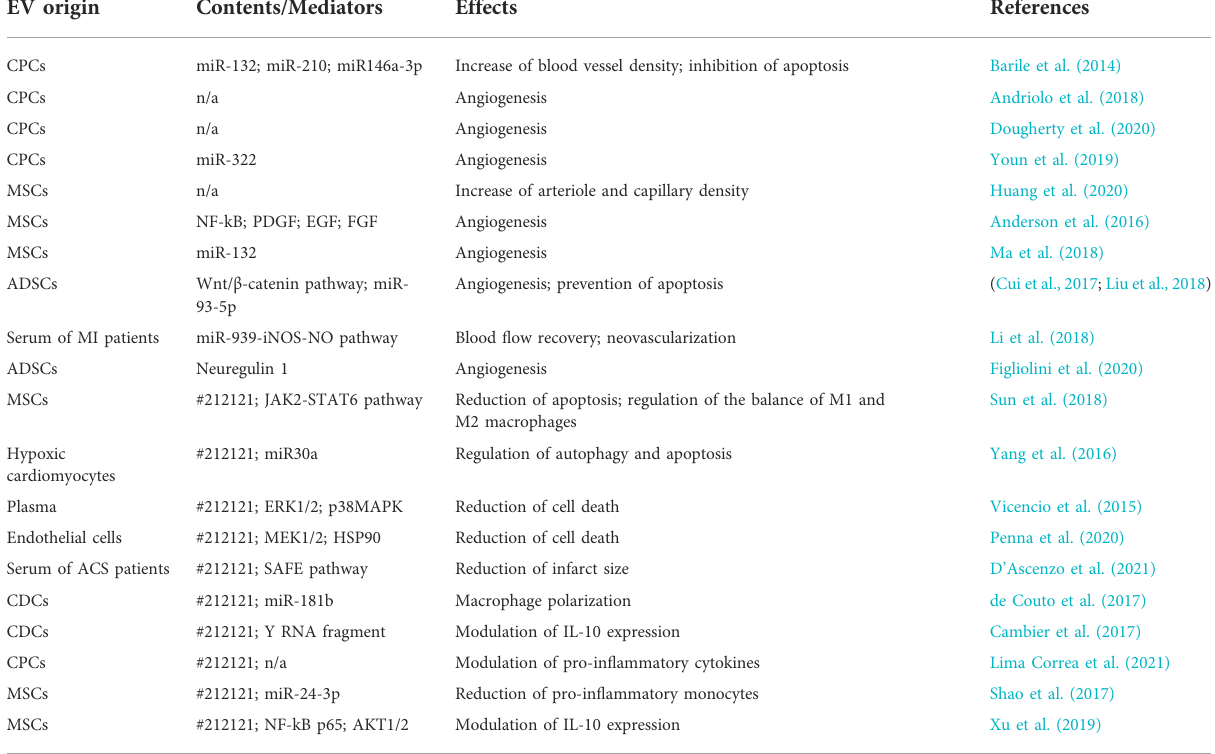
TABLE 1 Summary of studies reporting EV-mediated effects in cardiac repair.